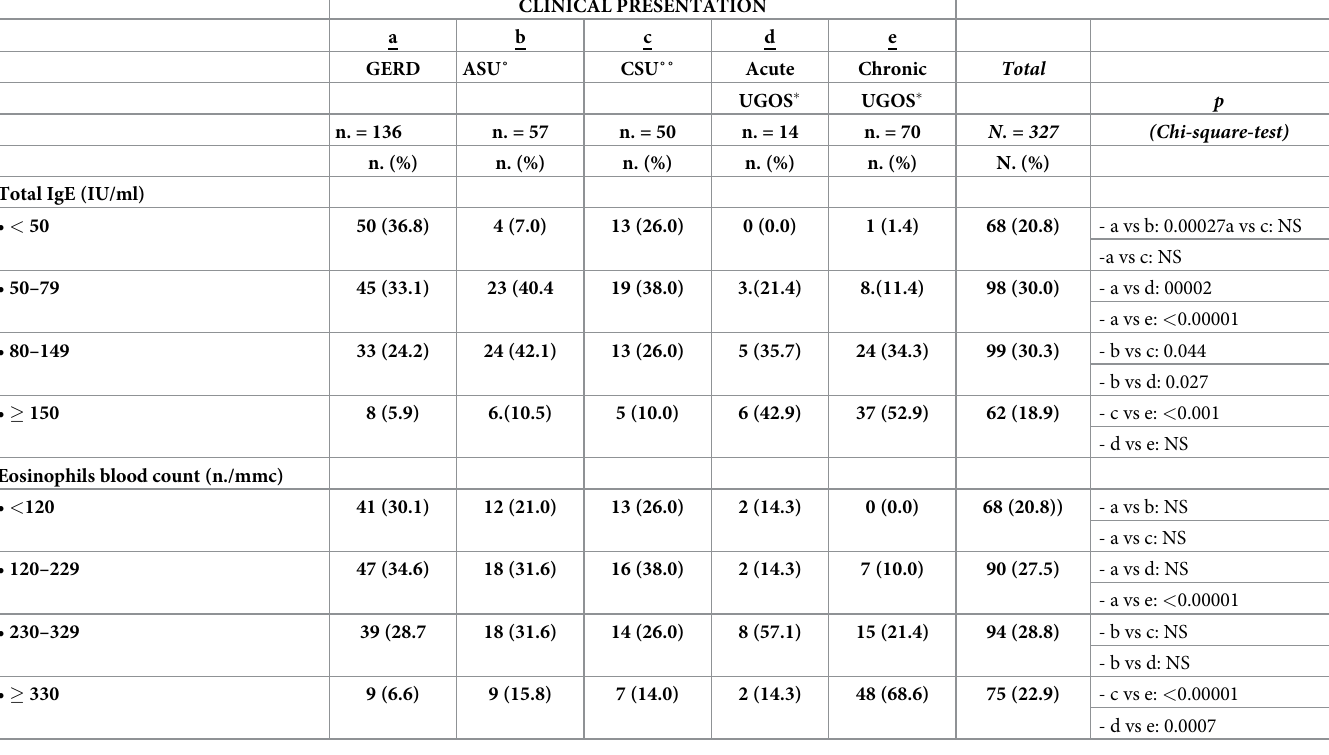
Table 4. Total IgE and Eosinophils blood count analysed by different clinical presentations and after recoding into categories of approximately equivalent size patients suffering from gastroesophageal reflux disease (GERD) and/or urticaria. CLINICAL